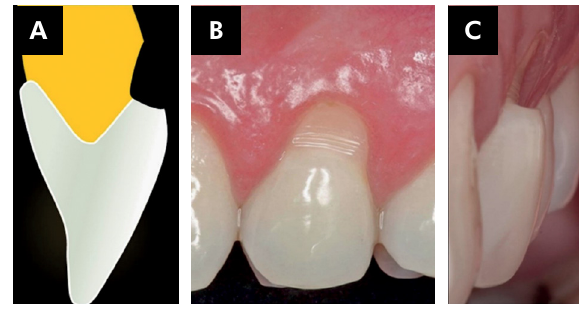
Figure 4. Schematic view of the B+ tooth surface. A deep non-carious cervical lesion (NCCL) is associated with gingival recession (GR) affecting both crown and root surfaces; there is a step at the level of the coronal border of the NCCL (a). Facial view of a combined defect (CD) with recession type 1 GR and B+ NCCL (b). Lateral view of the same CD. Note that the cementoenamel junction was lost, with the presence of a step